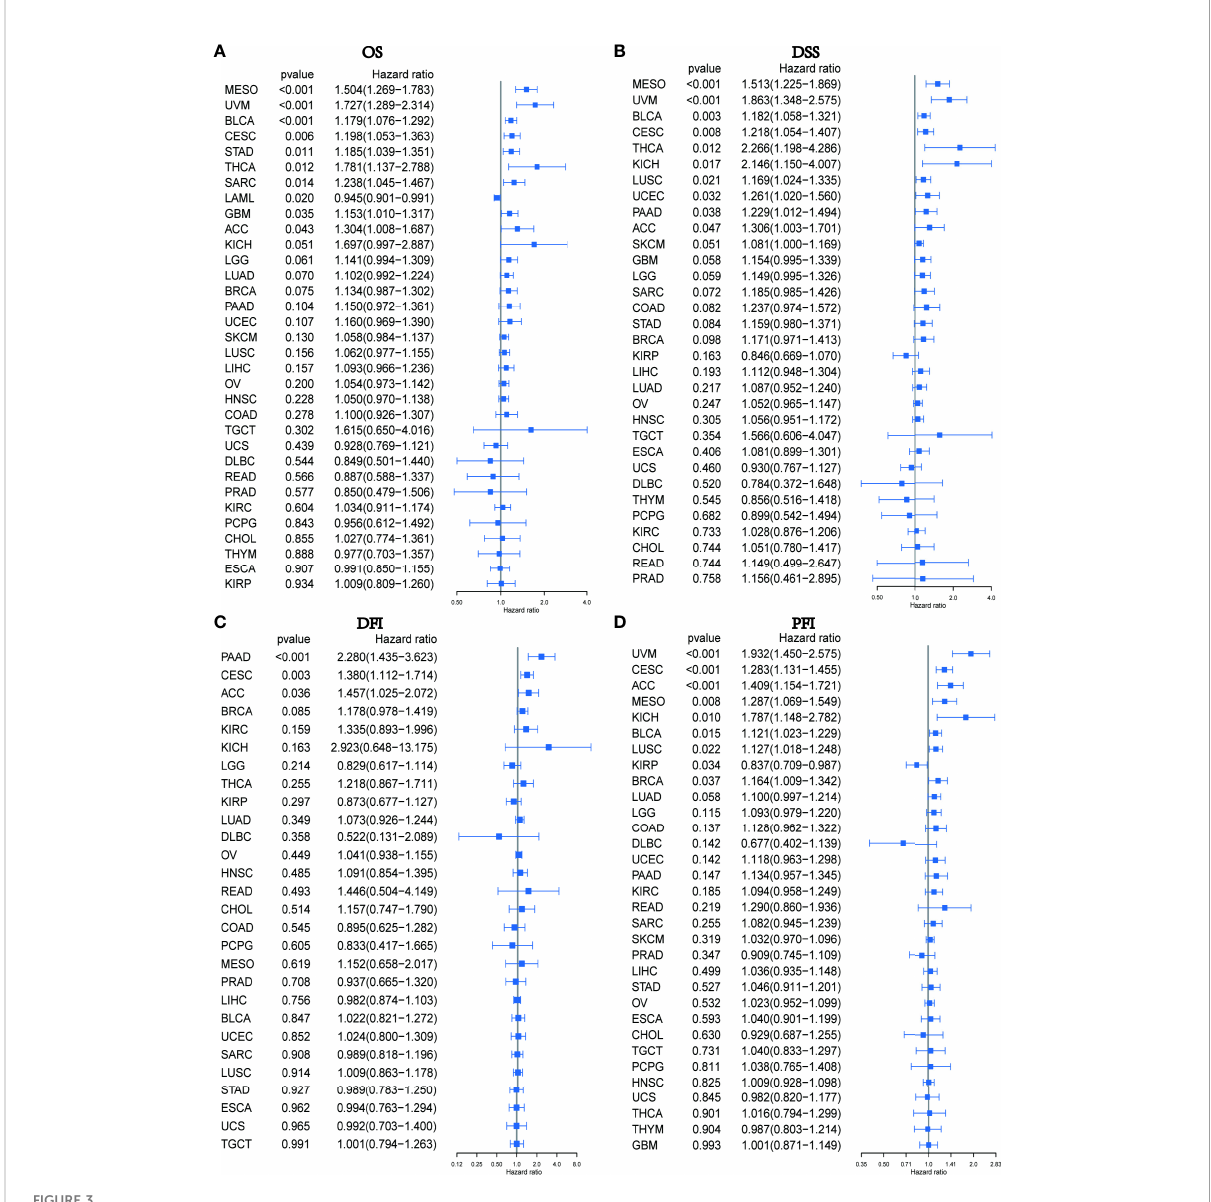
FIGURE 3 Relationship between PXDN expression and OS, DSS, DFI and PFI. (A) Expression of PXDN is associated with OS in 33 tumour types. (B) Expression of PXDN is associated with DSS in 32 tumour types. (C) Expression of PXDN is associated with DFI in 32 tumour types. (D) Expression of PXDN is associated with PFI in 32 tumour